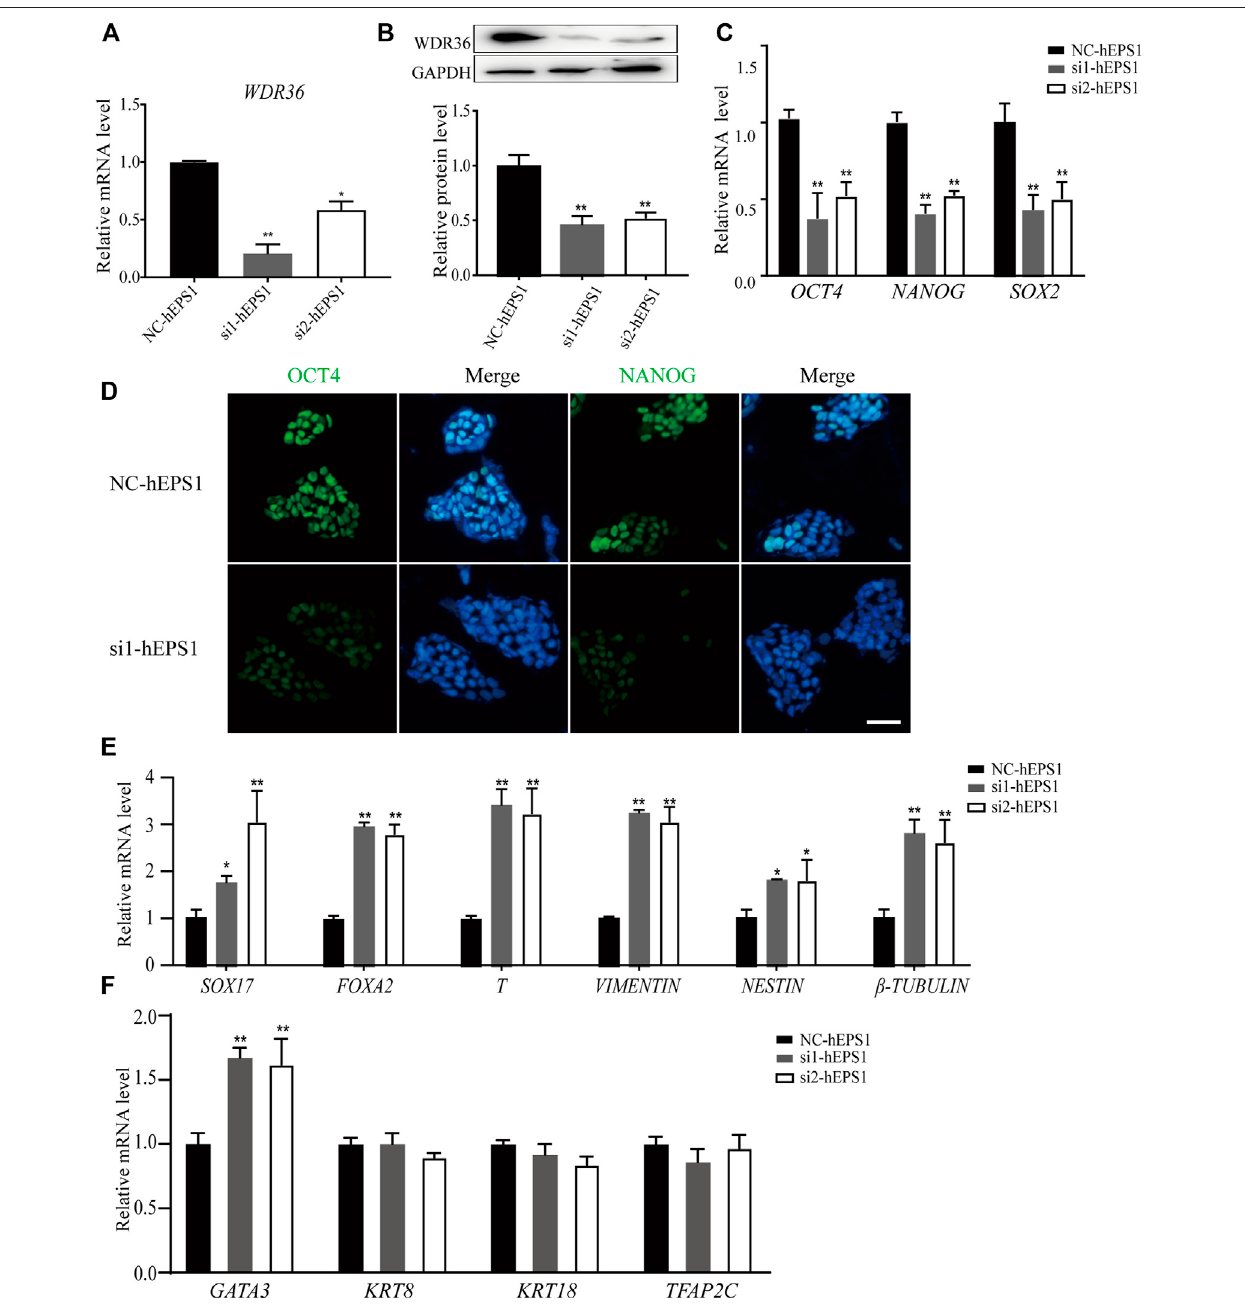
FIGURE2| siRNA-WDR36wouldimpairself-renewalofhEPS1cells. (A,B) WDR36expressionlevelinhEPS1cellswhichhadbeentransfectedwithWDR36siRNA was determined using qRT-PCR (A) and western blotting (B) . (C) Expression of OCT4 , NANOG and SOX2 mRNA in hEPS1 cells transfected with WDR36 siRNA. (D) Immuno fl uorescentimagesof OCT4 and NANOG inhEPS1cellswithWDR36siRNA.Bar=50 μ m. (E,F) Expressionofthreeembryonicgermlayerrelatedgenes (E) and extraembryonicdifferentiationrelatedgenes (F) insiRNA-WDR36hEPS1cells. n =3experiments;mean±S.D;two-tailedStudent ’ st-test.*,0.01 < p < 0.05;**, p < 0.01; no labeling indicates no statistical signi fi cance. NC-hEPS1: hEPS1 transfected with siRNA-scramble; si1-hEPS1 and si2-hEPS1: hEPS1 transfected with small interference RNA 1 or RNA 2 of WDR36 respectively.